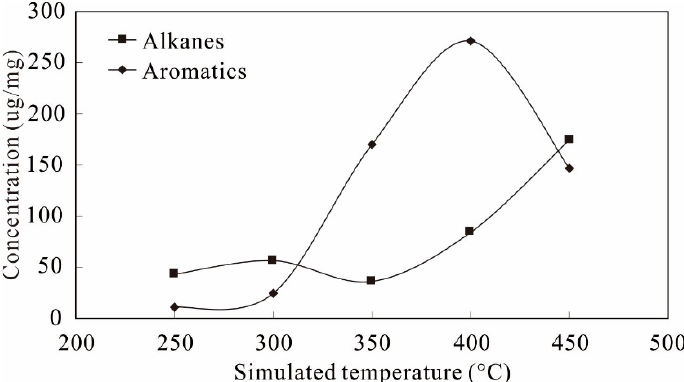
Figure 3. The distribution of alkanes and aromatics with increasing temperature.